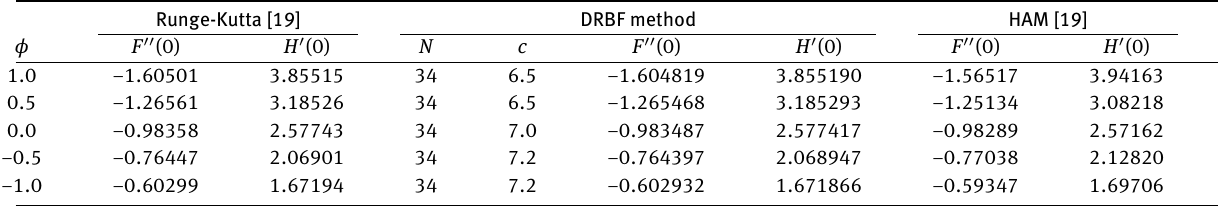
Table 4: Comparison between direct RBFs and other solutions of F (cid:48)(cid:48) (0) and H (cid:48) (0) for some ϕ at β = 6 and ε = 0.1 .